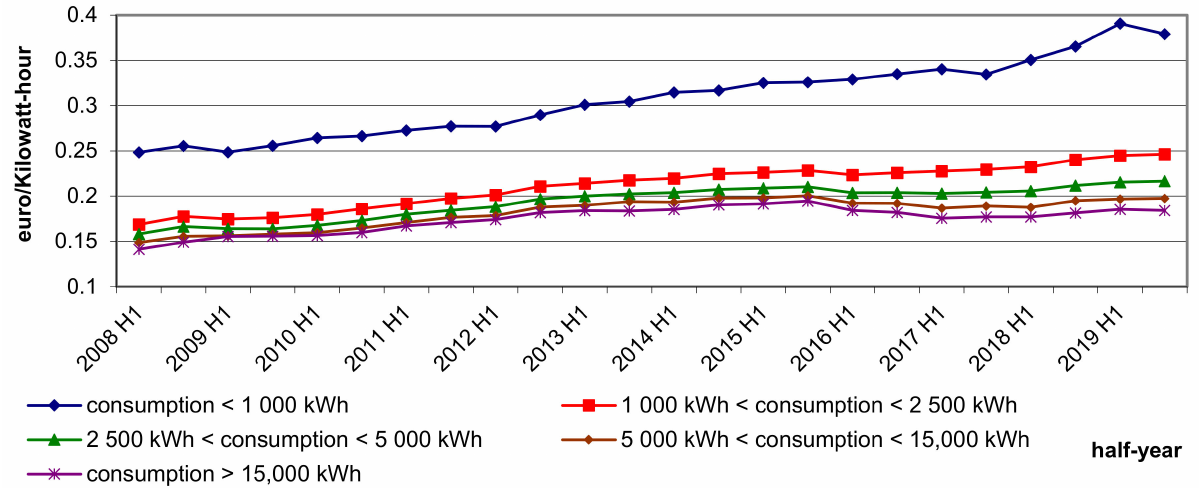
Figure 2. Electricity prices for private customers in European Union in 2008–2019.